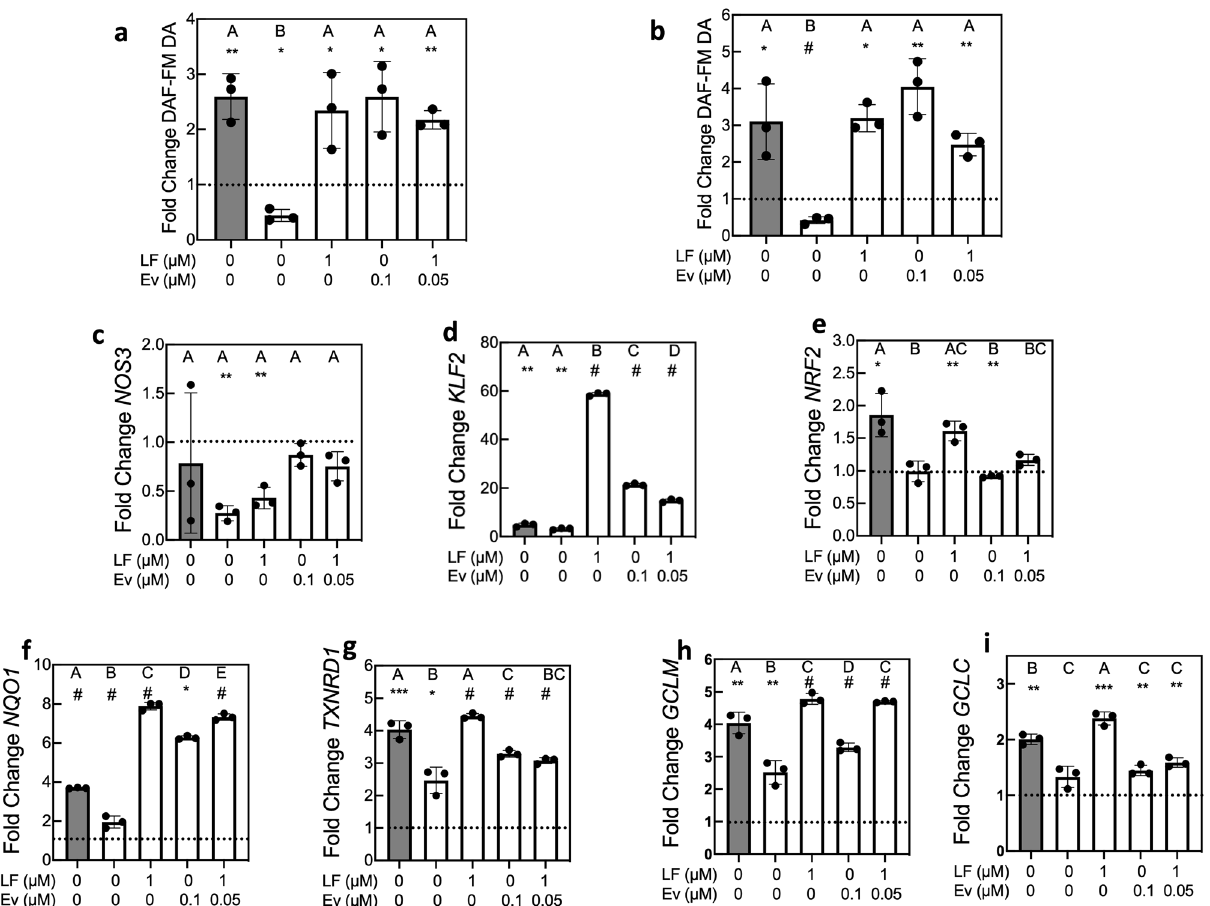
Figure 3. Lonafarnib and Everolimus improve NO production and flow-mediated gene expression in HGPS viECs exposed to physiological shear stress. ( a , b ) DAF-FM diacetate (DA) mean fluorescence intensity (MFI) in healthy (gray), HGPS 167 CL2 ( a ), and HGPS 003 CL1D ( b ) viECs exposed to 12 dynes/cm 2 for 24 h. Data presented as fold change DAF-FM DA MFI under shear stress compared with static condition from the same group. Gray bar represents healthy viECs. ( c - i ) Gene expression of ( c ) NOS3 , ( d ) KLF2 , ( e ) NRF2 , ( f ) NQO1 , ( g ) TXNRD1 , ( h ) GCLM, and ( i ) GCLC in HGPS 167 CL2 viECs exposed to 12 dynes/cm 2 . Data were normalized to GAPDH expression and gene expression in viECs exposed to shear stress was normalized to respective viECs under static culture from the same group. Dashed line indicates normalized static control. Data presented as mean ± SD. N = 3 experiments per group. Asterisks indicate significant differences between each shear stress value and its own static control: *p < 0.05, **p < 0.01, ***p < 0.001, # p < 0.0001. Letters indicate significant differences between treatment groups under shear stress: groups labeled with different letters are significantly different from each other (p < 0.05). Exact p-values for significant differences for comparisons between treatment groups under shear stress are provided in Table